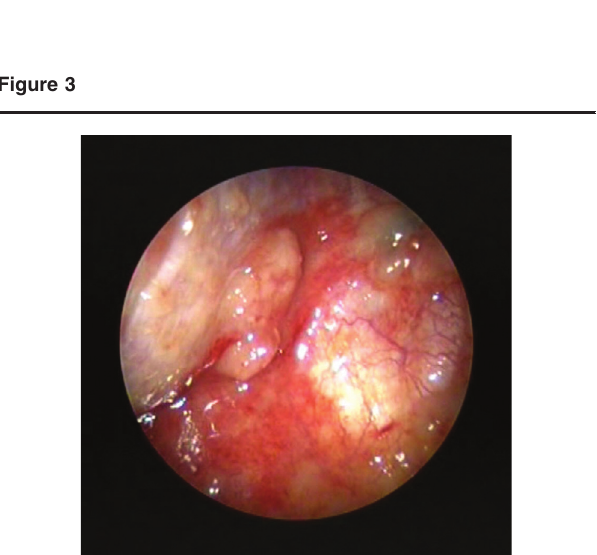
A gig mass over visceral pleura and small scattered nodules over both visceral and parietal pleurae, biopsies were taken revealed malignant mesothelioma.